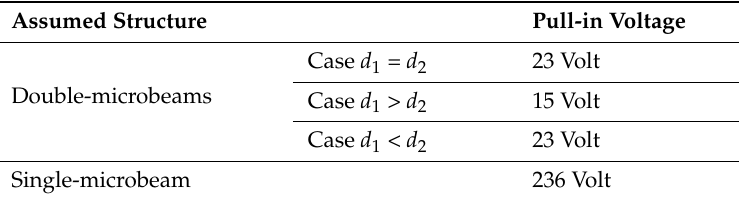
Table 2. Comparison of pull-in voltage of all cases shown in Figure